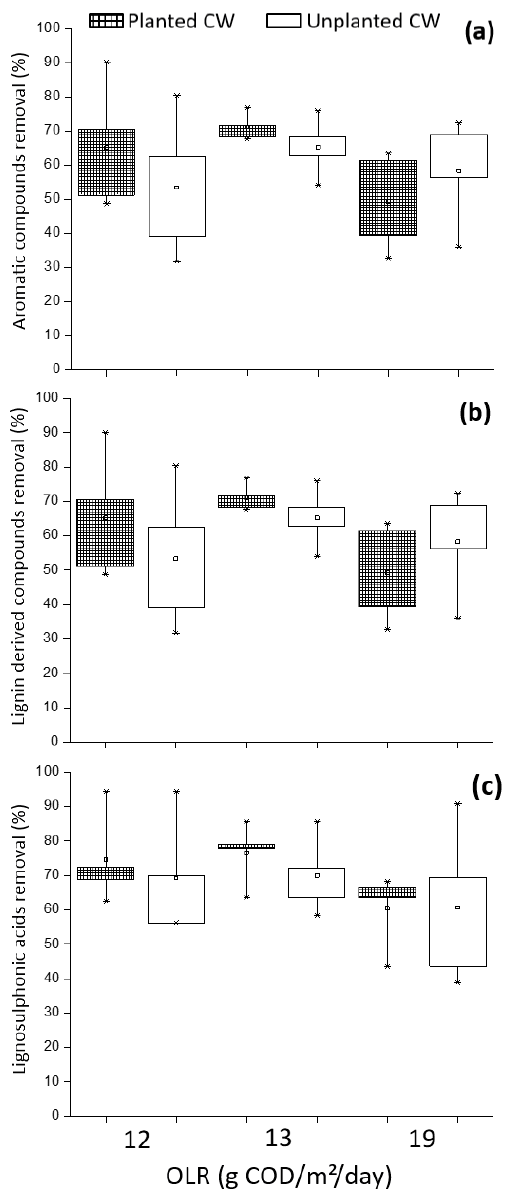
Figure 2. Removal efficiency of ( a ) aromatic compounds; ( b ) lignin-derived compounds; and ( c ) lignosulphonic acids contained in P. radiata leachate treated in the planted and unplanted CW.